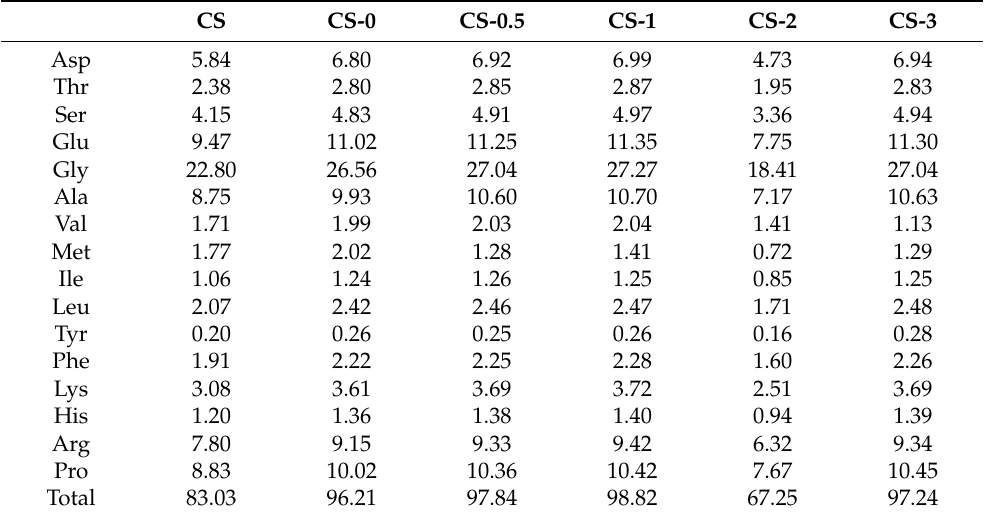
Table 4. Amino acid composition (Amino acids g/100 g protein) of Coregonus peled scale gelatin.